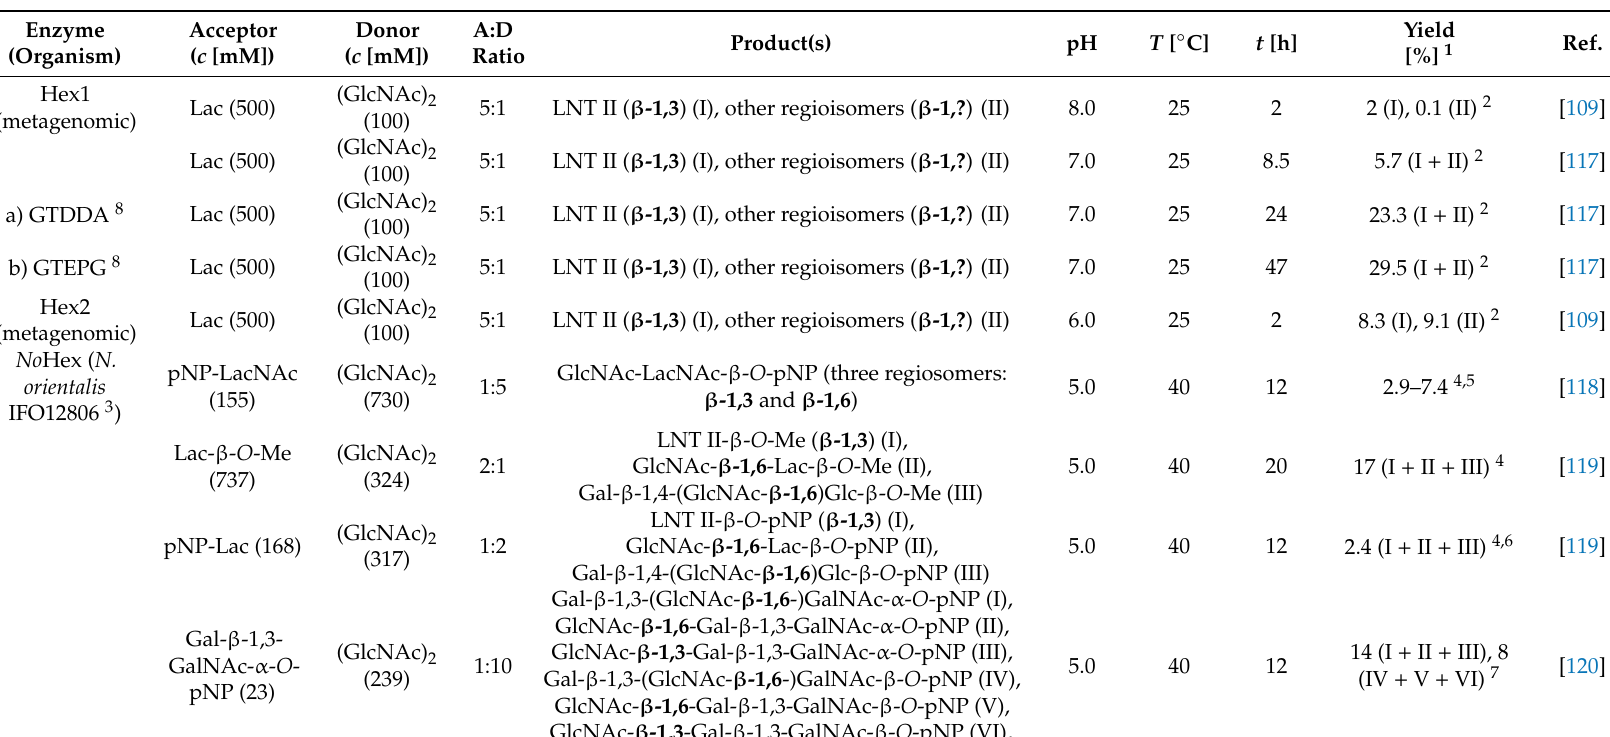
Table 8. Trans-glycosylation reactions catalyzed by GH20 β - N -acetylhexosaminidases using chitobiose donor substrates. New bonds are highlighted in